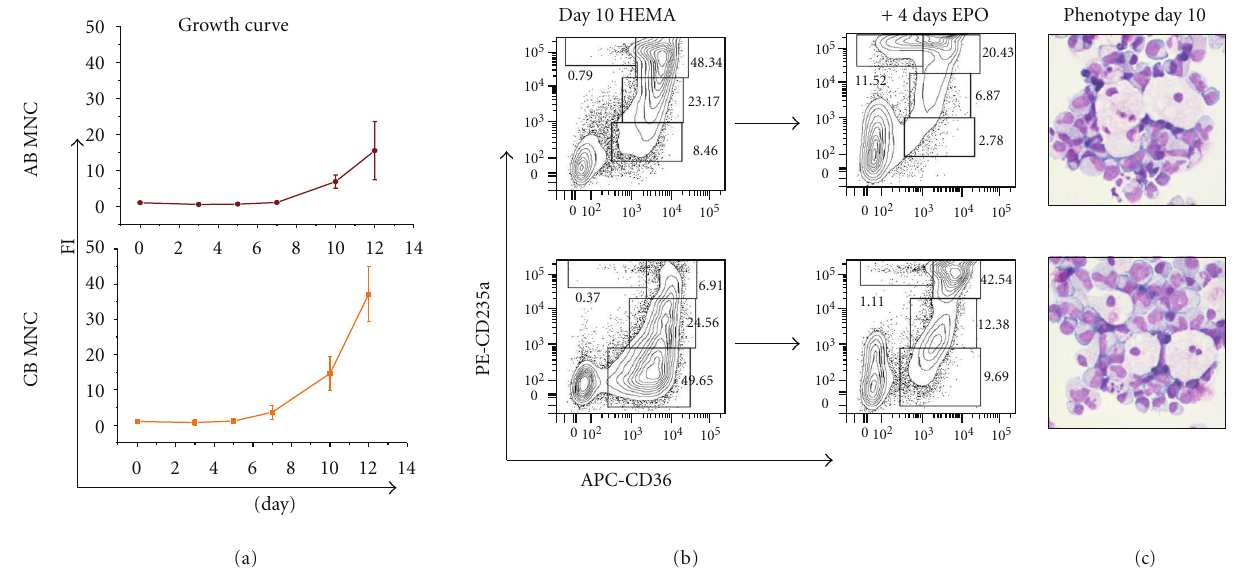
Figure 1: MNC from AB and CB generate great numbers of EBs under HEMA conditions. (a) Cell number (as Fold Increase, FI, with respect to day 0), (b) maturation profile (cytofluorimetric analysis on the basis of the expression of CD36 and CD235a), and (c) representative morphology (by May-Grunwald staining) of EBs generated in HEMA culture seeded with MNC from either CB or AB. The ability of CB and AB EBs obtained at day 10 to proceed along the maturation pathway after 4 days of culture in the presence of EPO only is also compared (b). The flow cytometric profile used to define EBs maturation is presented in Supplemental Figure 3. The flow charts are representative of those obtained in at least three independent experiments with MNC from di ff erent CB or AB donors. The numbers in the quadrants present the frequency of EBs in the gates R1 to R4. Frequencies obtained in multiple experiments are presented as mean ( ± SD) in Table 1.